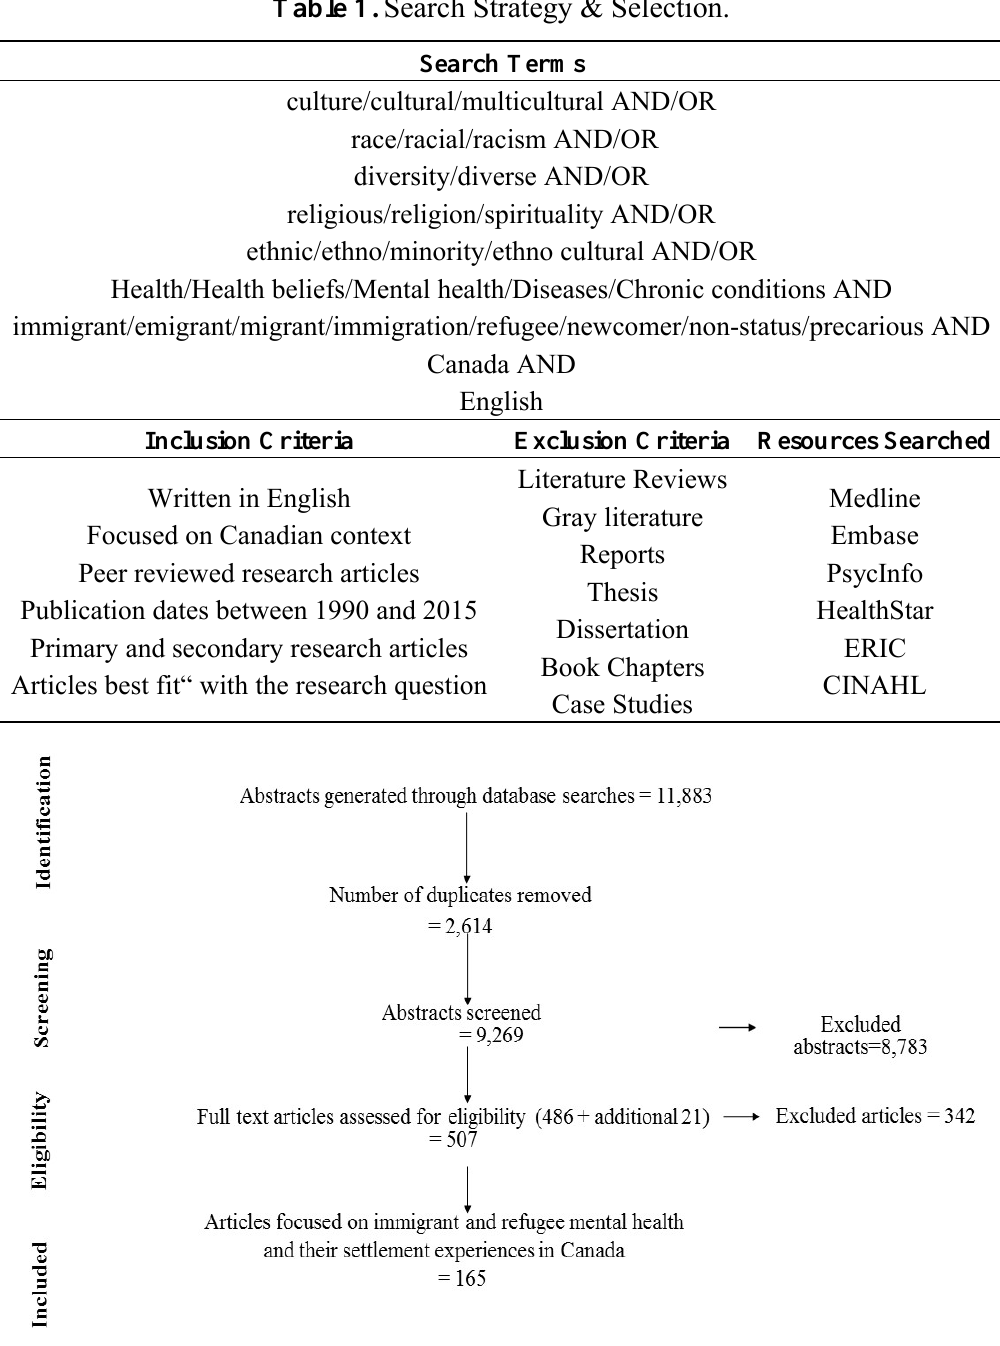
Figure 1. PRISMA flow diagram of review search screening